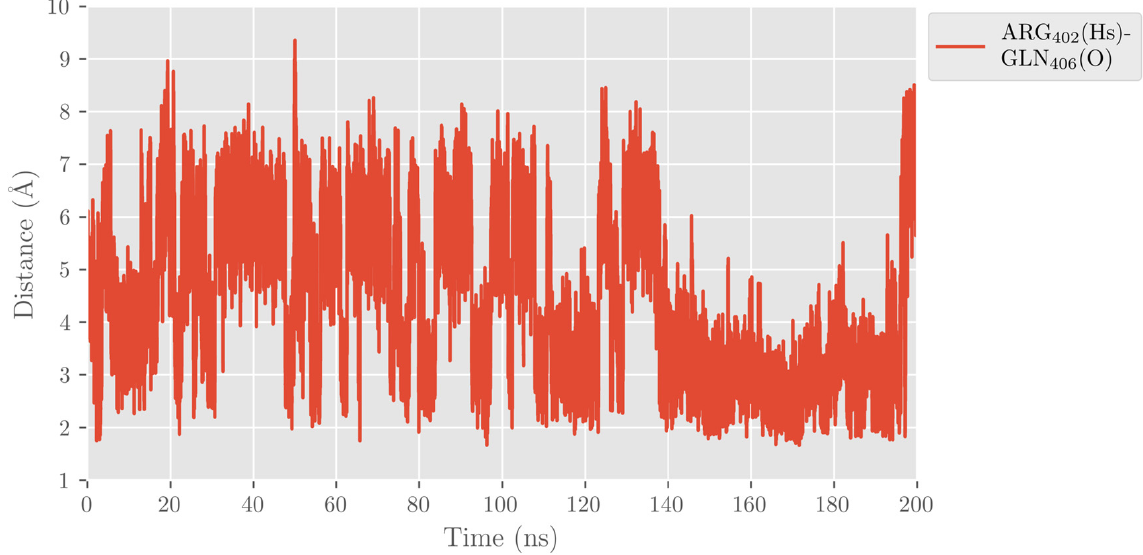
Figure 5. Distance between the oxygen atom in Gln406 and the closest hydrogen atom in Arg402 versus time for the MD replica 1 in hALOX12.